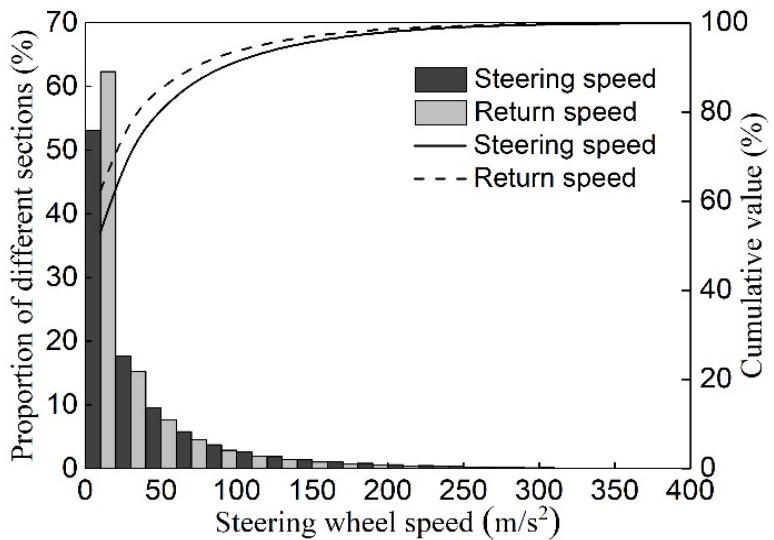
Figure 9. The distribution characteristic of steering wheel speed.